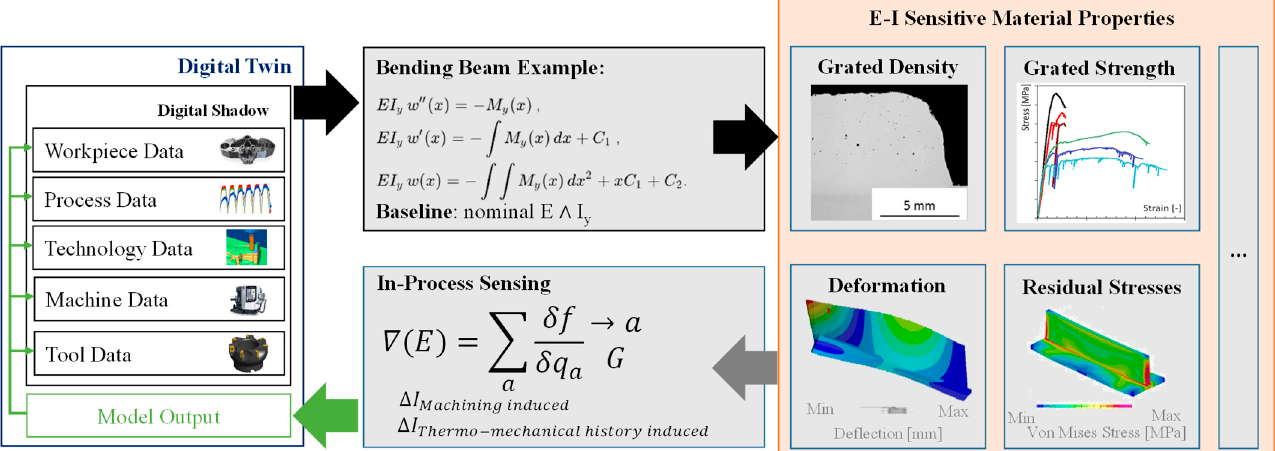
Figure 7. Illustration of the baseline with nominal material properties using the example of Young’s modulus and the second moment of inertia with the further discretization of property graduation induced by spatial deviation of material properties including feedback by the means of in ‐ process sensing and/or a material digital twin.